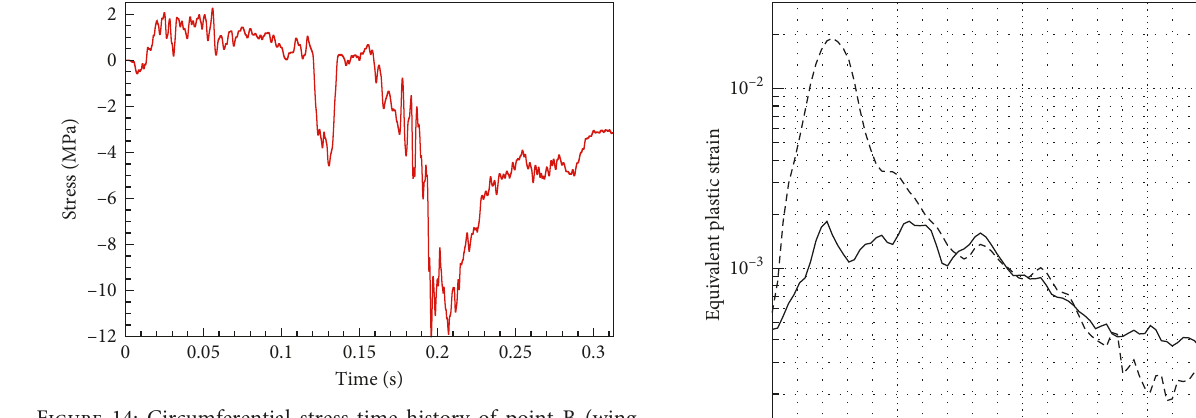
Figure 14: Circumferential stress-time history of point B (wing tank case).